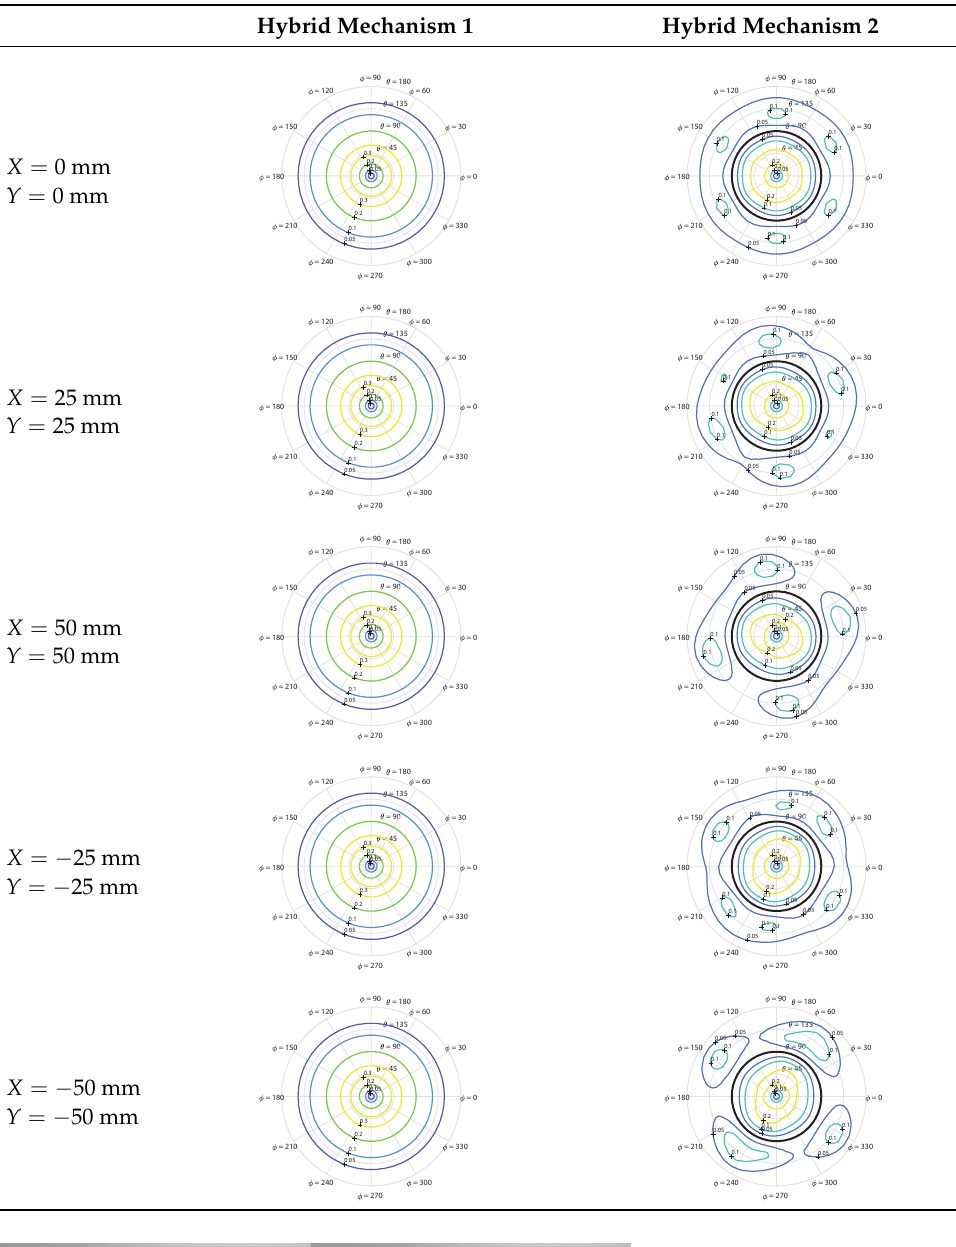
Table 2. Distribution of the inverse condition index for a given position.